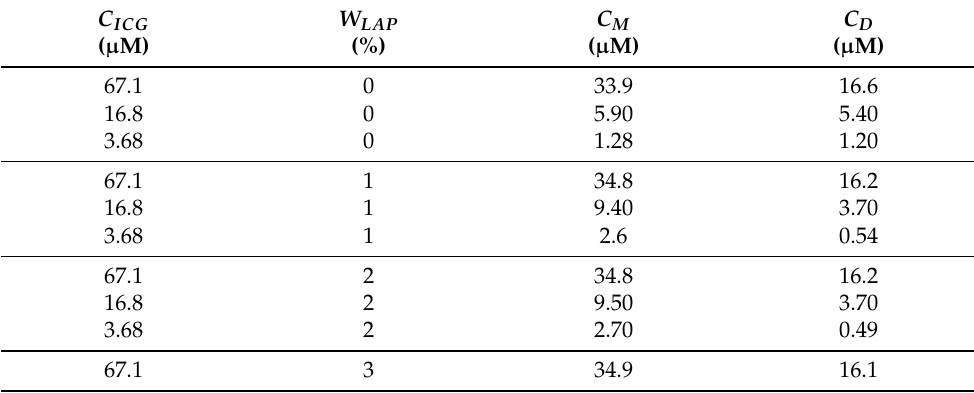
Table 1. Concentration of the monomer and of the dimer calculated with the deconvolution of the spectra with two Gaussian